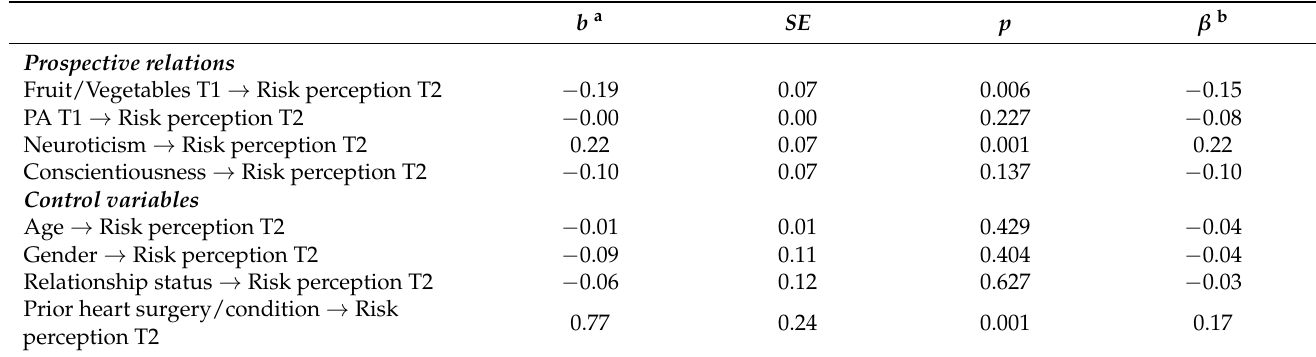
Table 3. Path model with risk perception at T2 as the outcome variable.